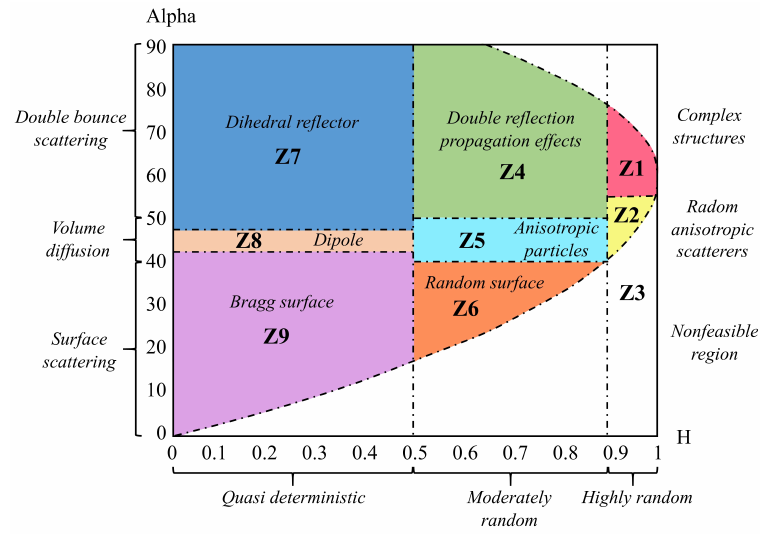
Figure 24. Classical H-Alpha classification template.